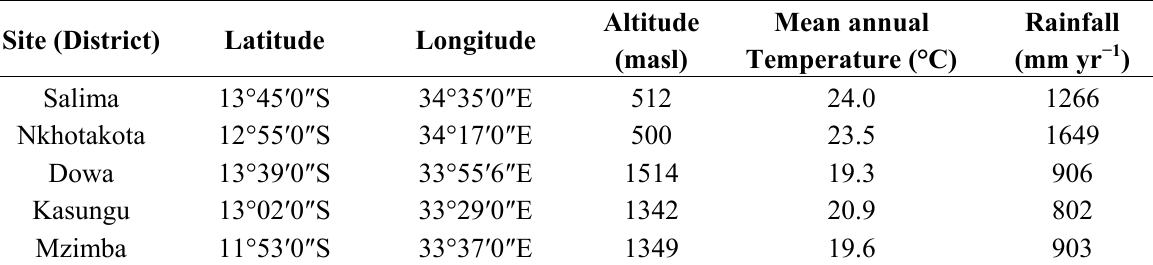
Table 1. Location and climatic conditions of study